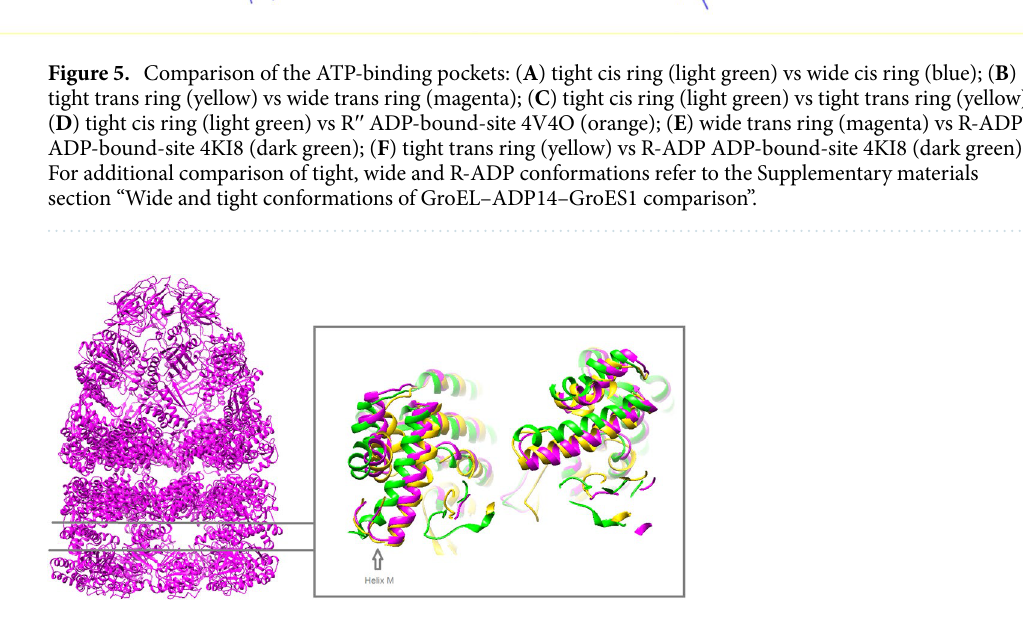
Figure 6. Comparison of the wide and tight conformations. Atomic model of the wide conformation (left) and a slice through the intermediate domains (right). On the right, the wide conformation (magenta) is aligned with the tight conformation (green) and 2c7d (gold); helix M of the intermediate domain is